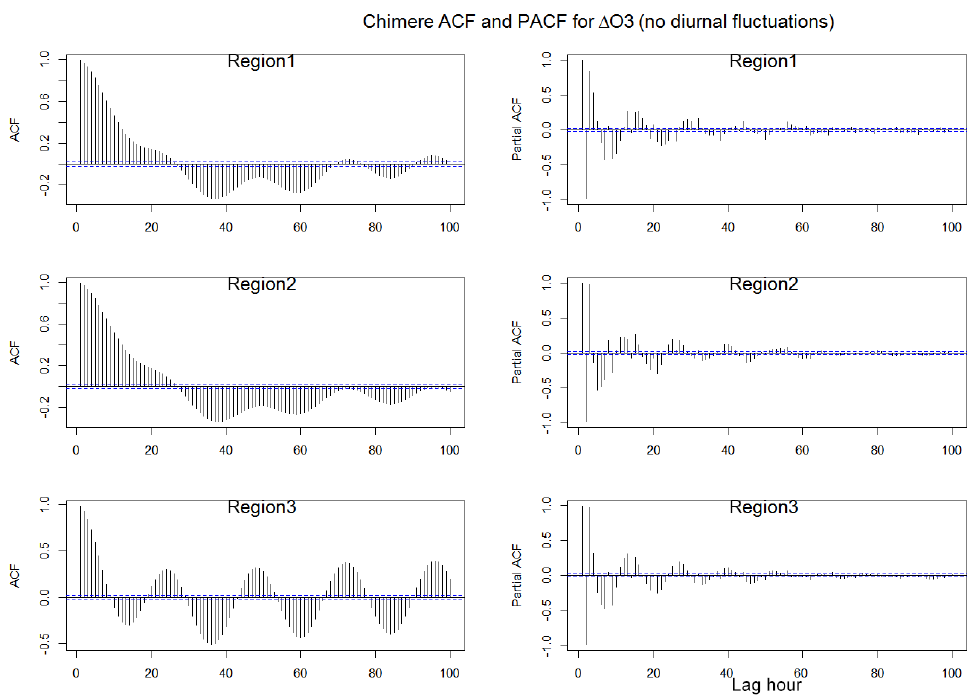
Figure 23. As in Fig. 22 for the differenced time series of residual of ozone obtained by filtering out the diurnal fluctuations from the modelled and observed time